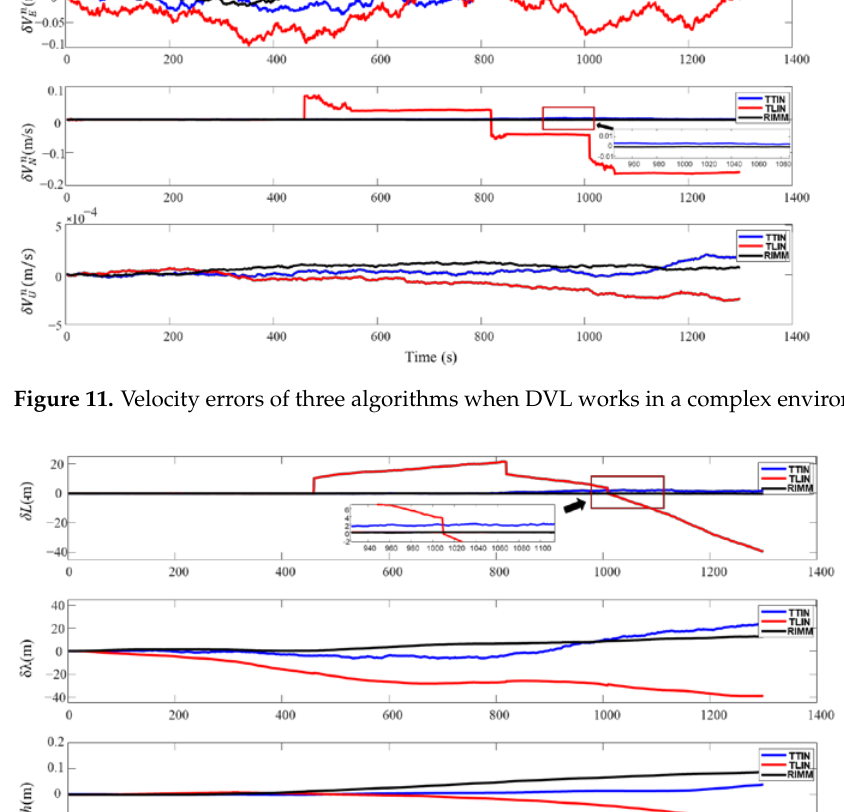
Figure 10. Variation of water flow velocity.